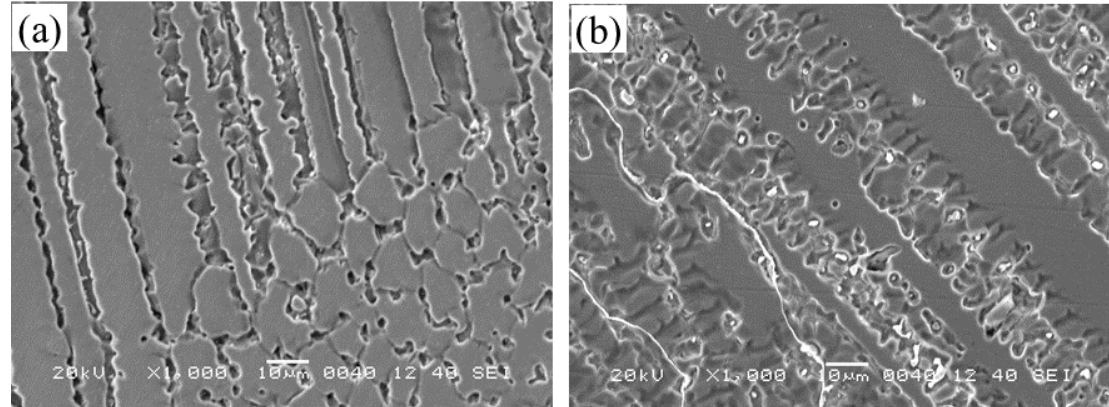
Figure 12. SEM images of corrosion: ( a ) image of the one-layer HX1 coating; ( b ) image of the two- layer HX2 coating.